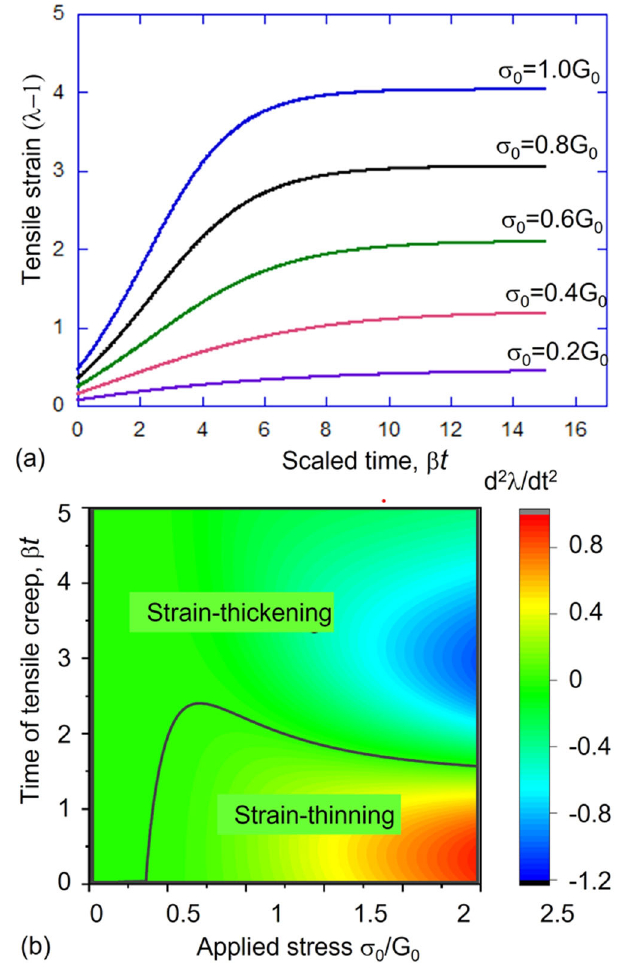
Fig.6|Rheologicalcharacteristicsofpartialvitrimers.a Thestrainevolutionon plastic creep of partial vitrimer with the exchangeable fraction ν =0.8, at different valuesofapplied engineeringstress (constantforce),aslabeledintheplot.Atlong times the deformation saturates at the level λ max given in the text. b The `phase diagram' mapping the regions of strainthickening and strainthinning for different applied stress and time of creep, again for the partial vitrimer with ν =0.8. Both plots are calculated numerically from the full solution of the constitutive Eq.